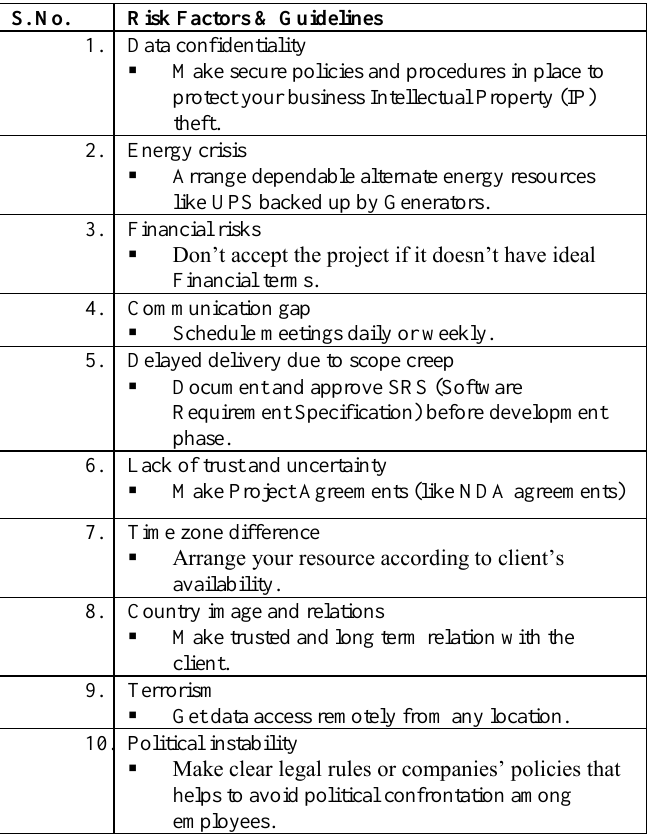
Table 4. Risk factors with